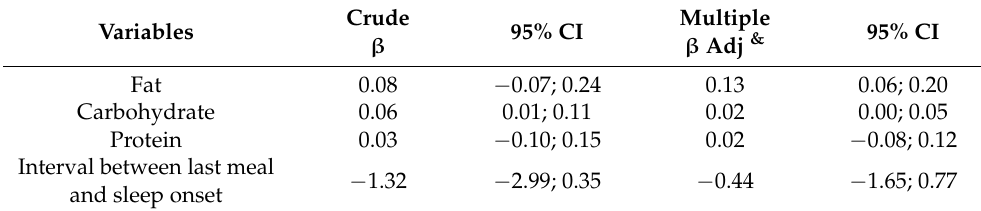
Table 3. Sleep onset latency after night shift (diurnal sleep) ( n =